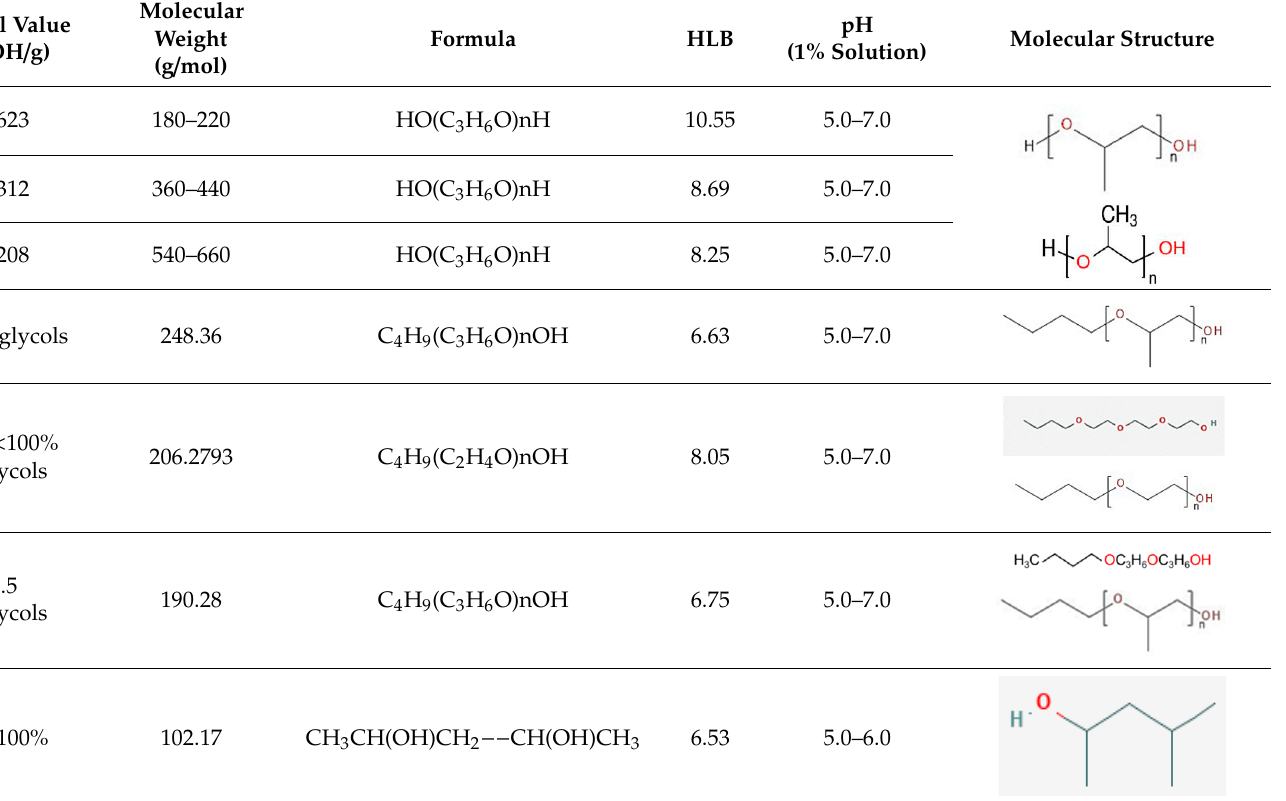
Table 1. Physical and chemical properties of frothers.